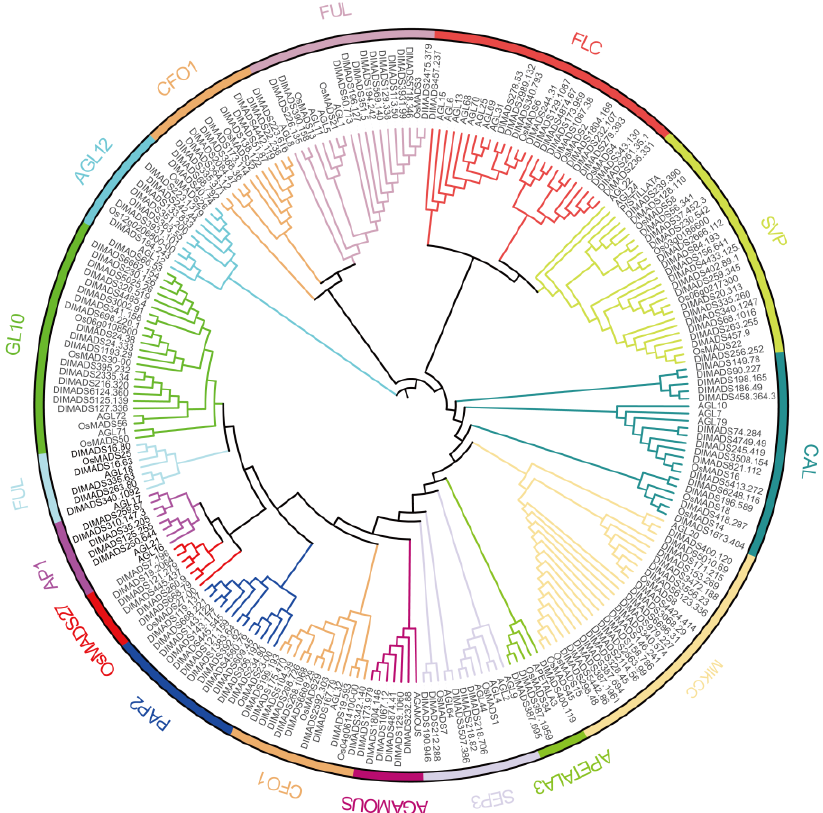
Figure 1. Phylogenetic analysis of MIKCc-type MADS-box proteins in D. latiflorus . A neighbor-joining (NJ) tree was constructed using 170 MADS-box sequence. The phylogenetic tree is clustered in 15 subfamilies, which are shown in different colors.